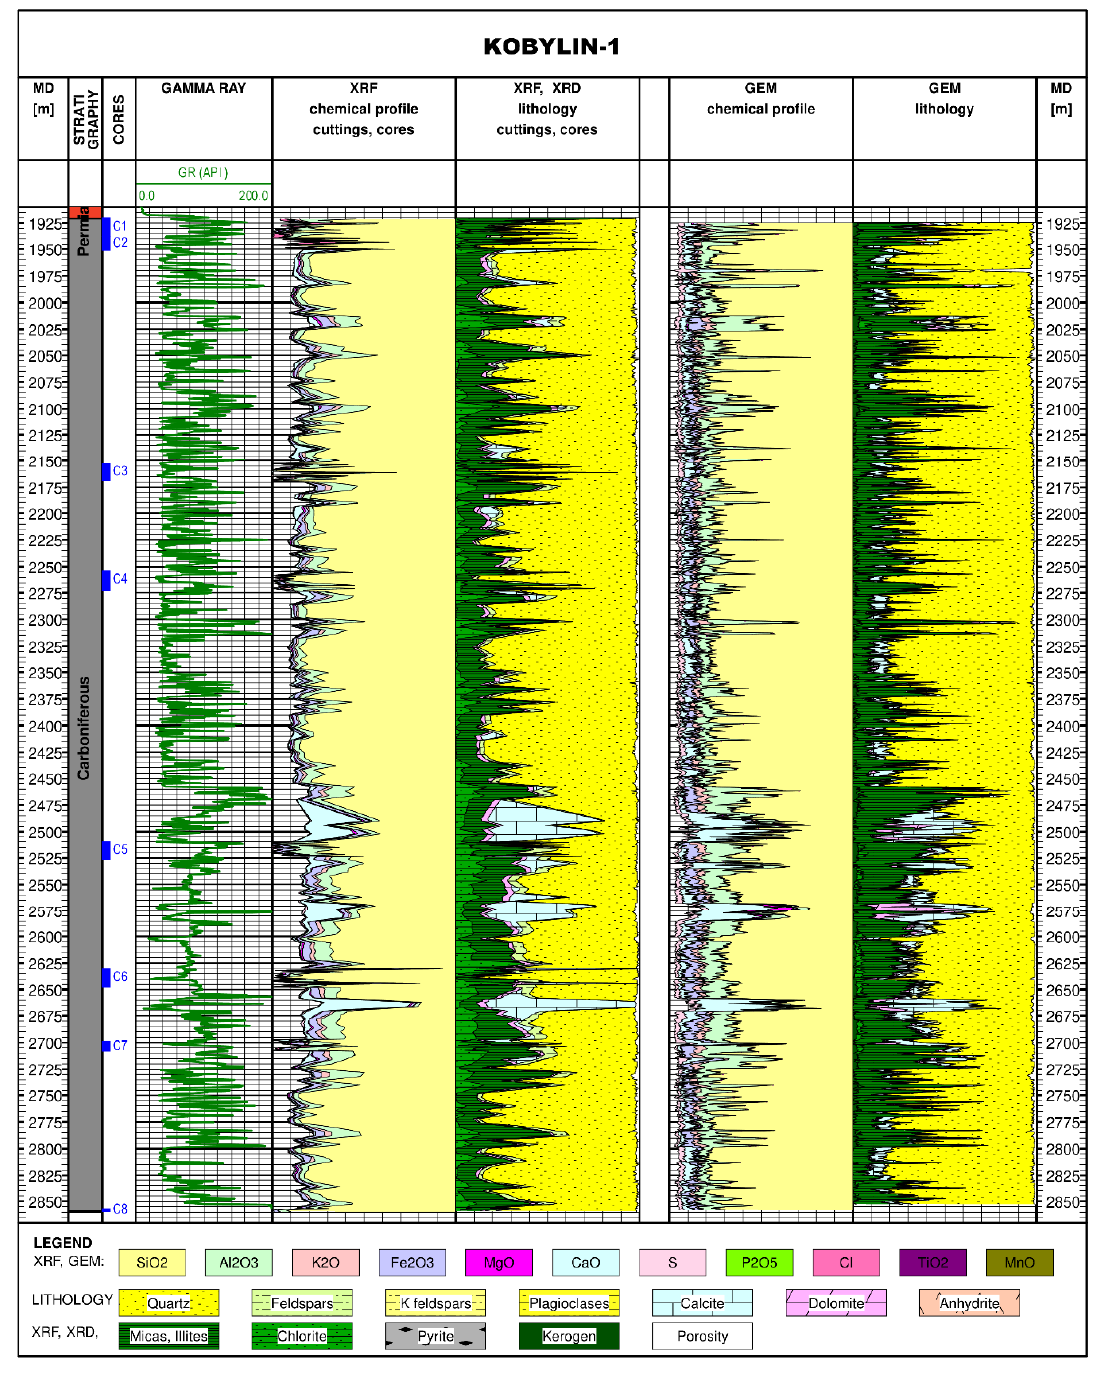
Figure 16. Juxtaposition of results regarding lithological profile reconstruction carried out in the Kobylin-1 borehole with a lithological profile interpretation based on GEM probe measurements.